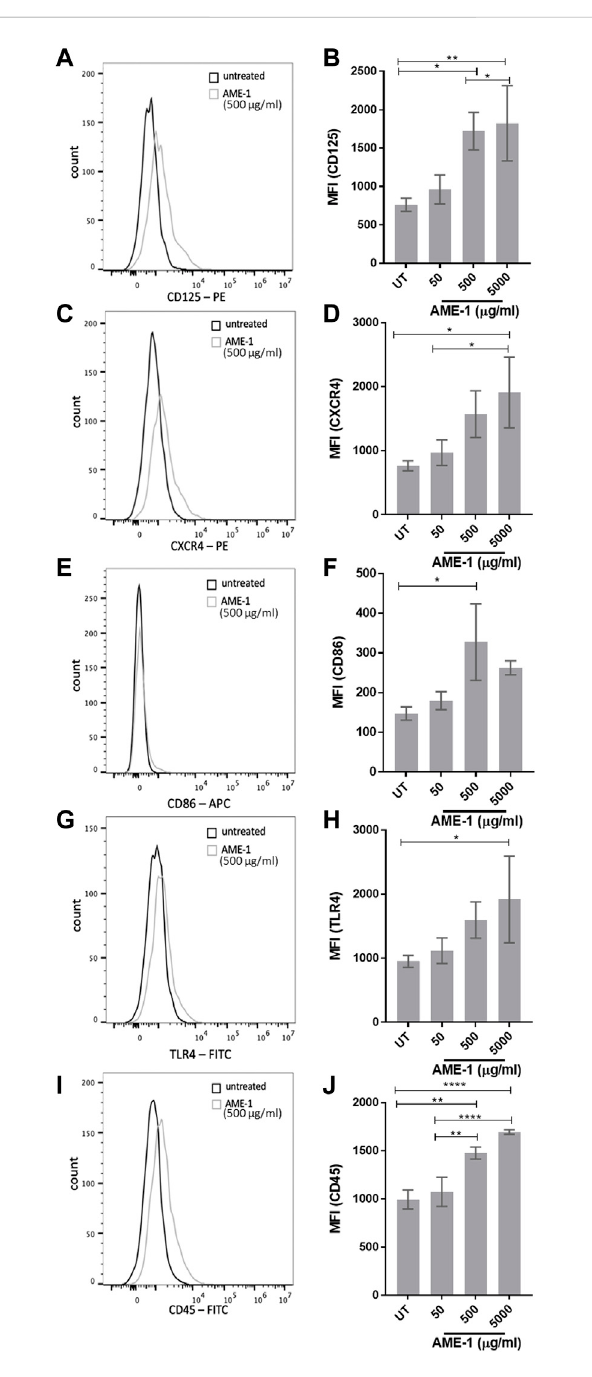
FIGURE 6 AME-1 signi fi cantly increases expression of CD125, CXCR4, CD86,TLR4,andCD45.MFIhistogramsandcorrespondingbargraphs of HMC3 treated with 50 – 5,000 μ g/mL of AME-1 for 24 h,labelled with (A, B) PE-CD125, (C, D) PE-CXCR4, (E, F) APCCD86, (G, H) FITC-TLR4 or (I, J) FITC-CD45 and analyzed via fl ow cytometry. Data shown in fl ow cytometry histograms is representative of